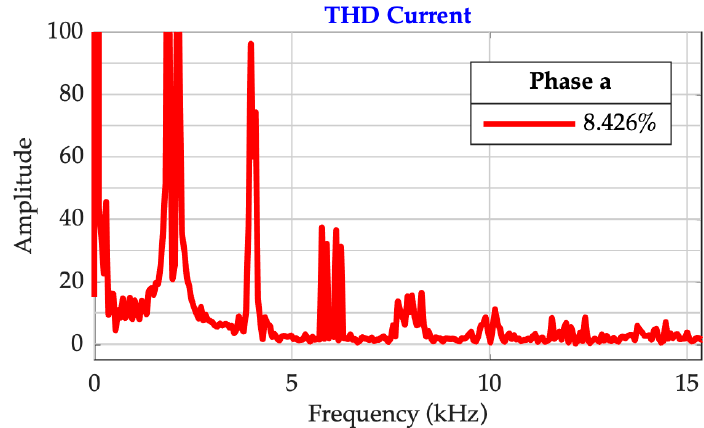
Figure 10. Total harmonic distortion (THD) current injected into the distribution grid without phase shift angle in the digital sinusoidal pulse width modulation (DSPWM) switching signals applied to the active front-end (AFE) converter.